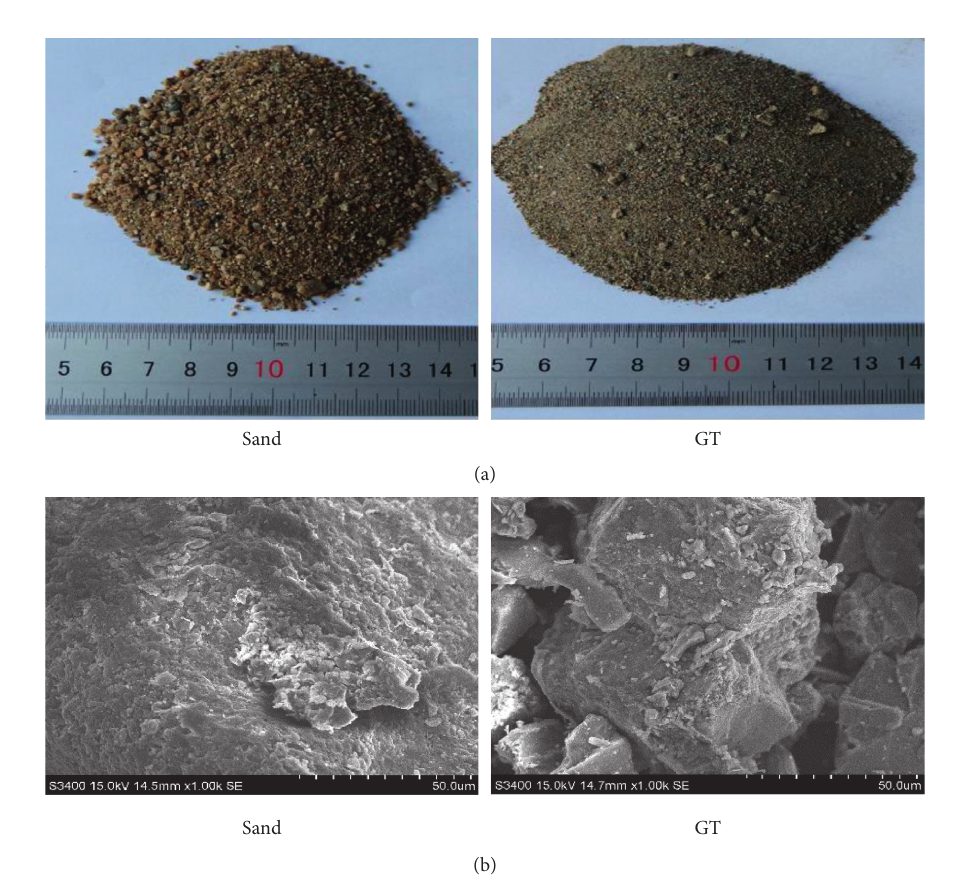
Figure 2: The apparent comparison of GT and sand: (a) apparent comparison; (b) SEM